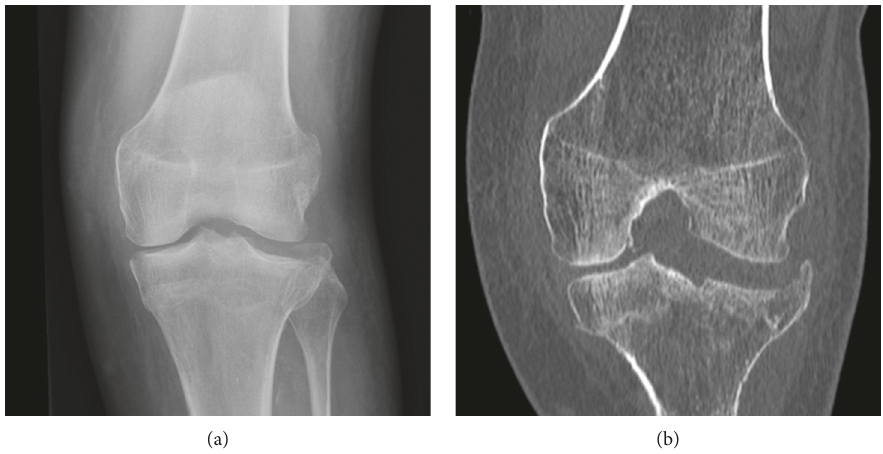
Figure 6: Patient 2 initial presentation. (a) Anterior-posterior radiograph and (b) coronal CT